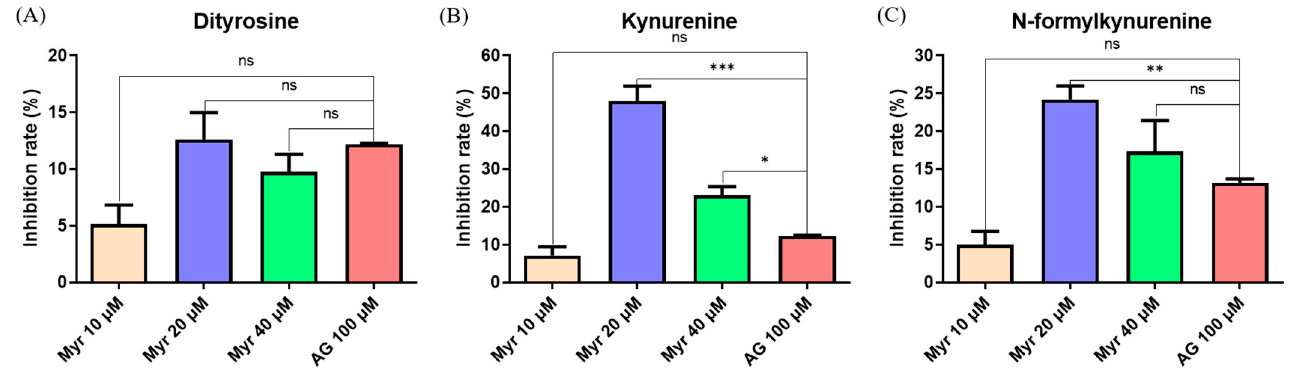
Figure 3. Effects of Myr on glycoxidation fluorescence products. Inhibition rates of formation of dityrosine ( A ), kynurenine ( B ) and N ′ -formyl-kynurenine ( C ), respectively, measured by fluorescence at 415, 480, and 434 nm with excitation at 330, 365, and 325 nm, respectively. Data were expressed as mean ± SD (n = 3). ns > 0.05, * p < 0.05, * p < 0.01 and *** p < 0.001 compared with AG.